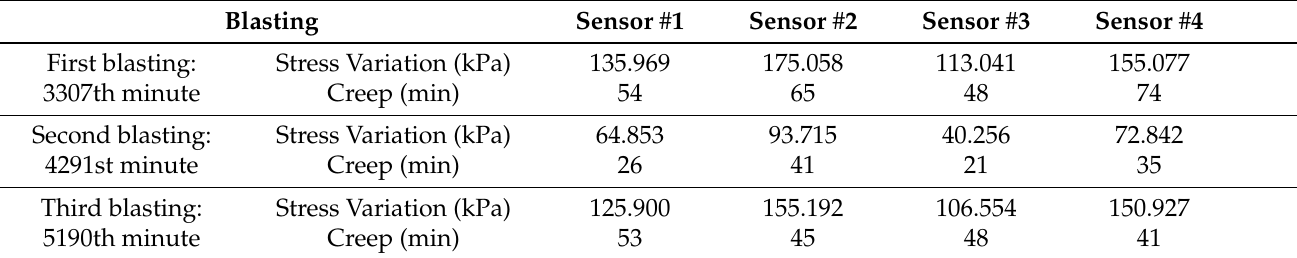
Table 2. Characteristics of stress during blasting recorded by